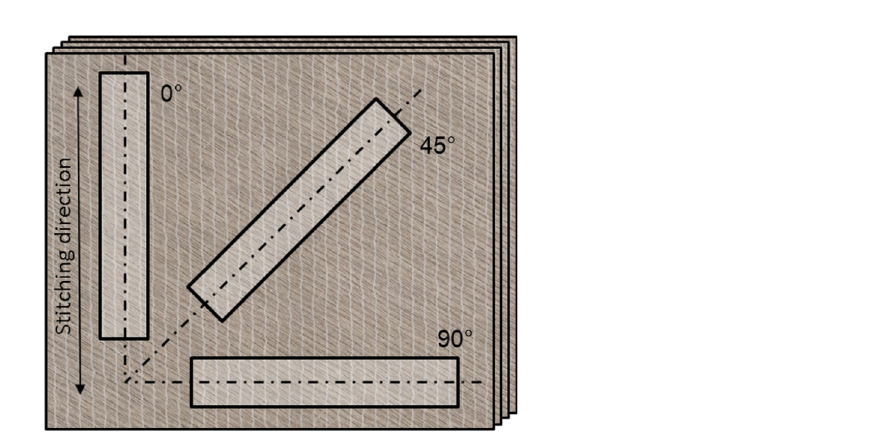
Fig 5. Cut out directions for tensile test specimens of multiaxial composite